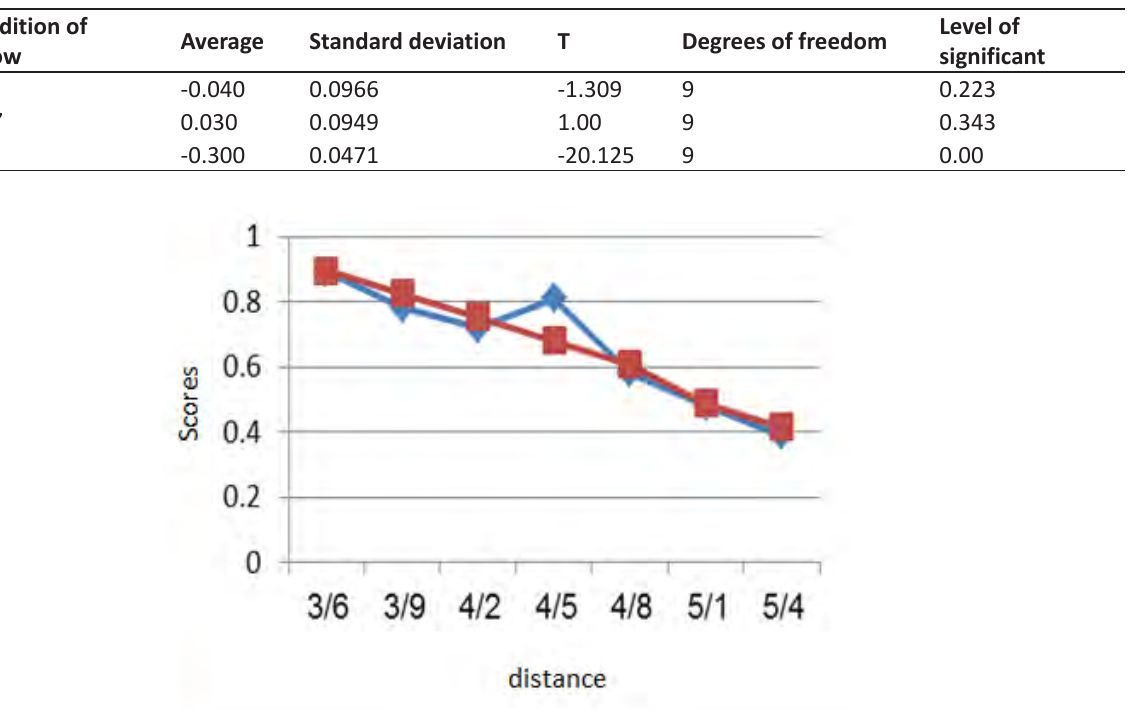
Figure 3. Actual success rates (blue line) from each of the seven positions for the group and predicted values based on regression analysis are displayed (red line) on the first